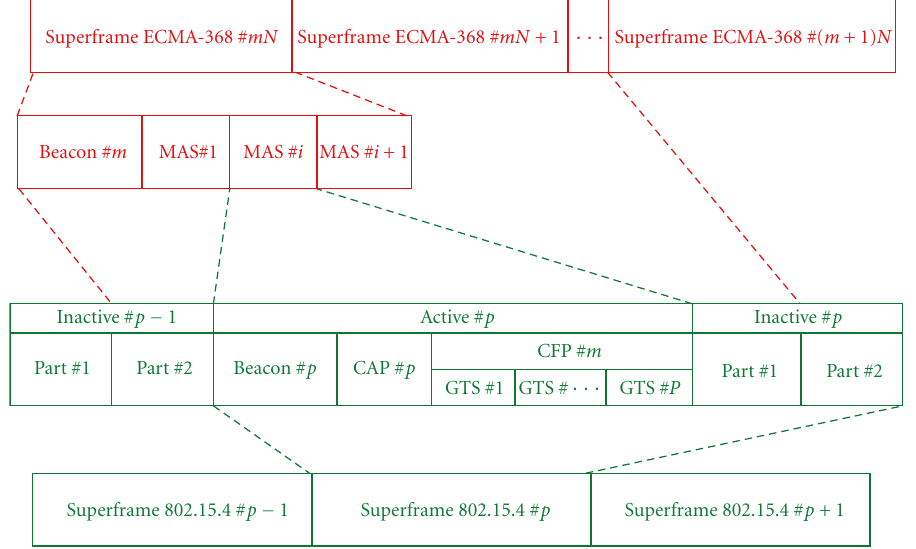
Figure 10: Interaction of the superframe structures for the improved AWA coexistence mechanism.